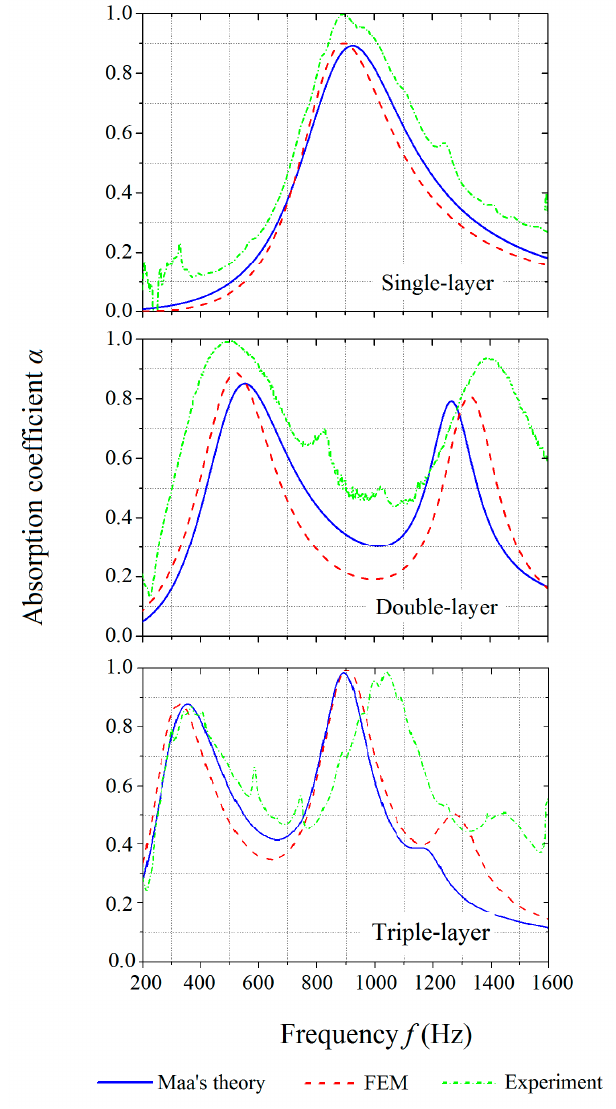
Figure 5. Comparison of the absorption coefficients of the single-layer, double-layer, and triple-layer MPPs obtained by the theoretical predictions, numerical simulations, and experiments.